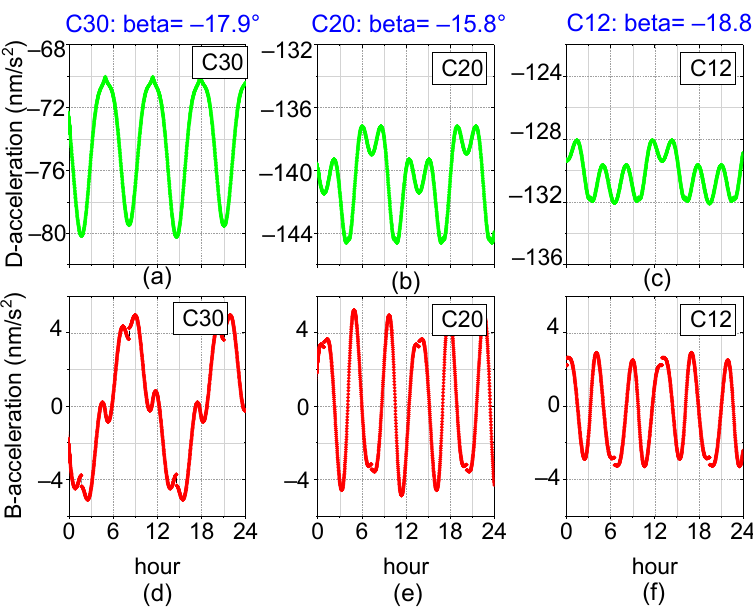
Figure 4 . D—(green scatters) and B—(red scatters) solar radiation accelerations derived from the adjustable box-wing (ABW) model. ( a – c ) are the D—accelerations for C30, C20, and C12, respectively; and ( d – f ) are the B—accelerations for C30, C20, and C12, respectively.